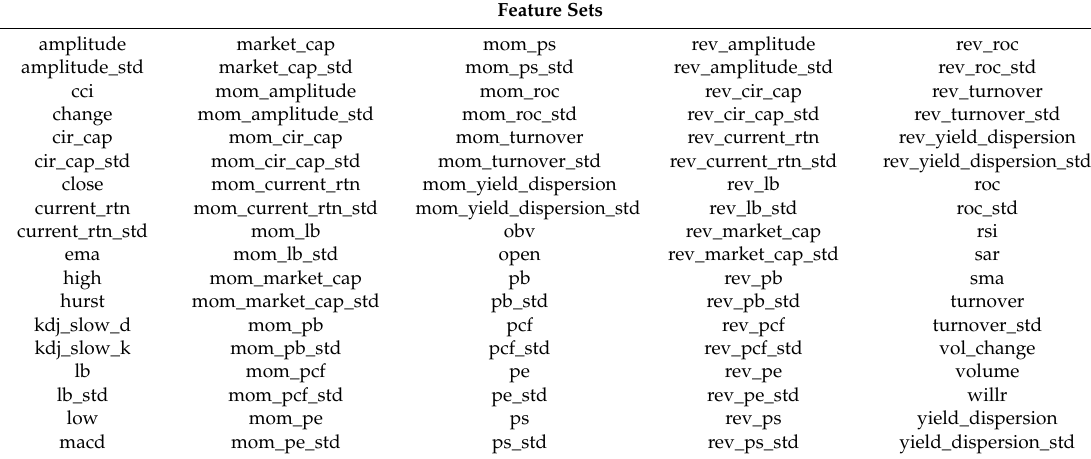
Table 2. Feature